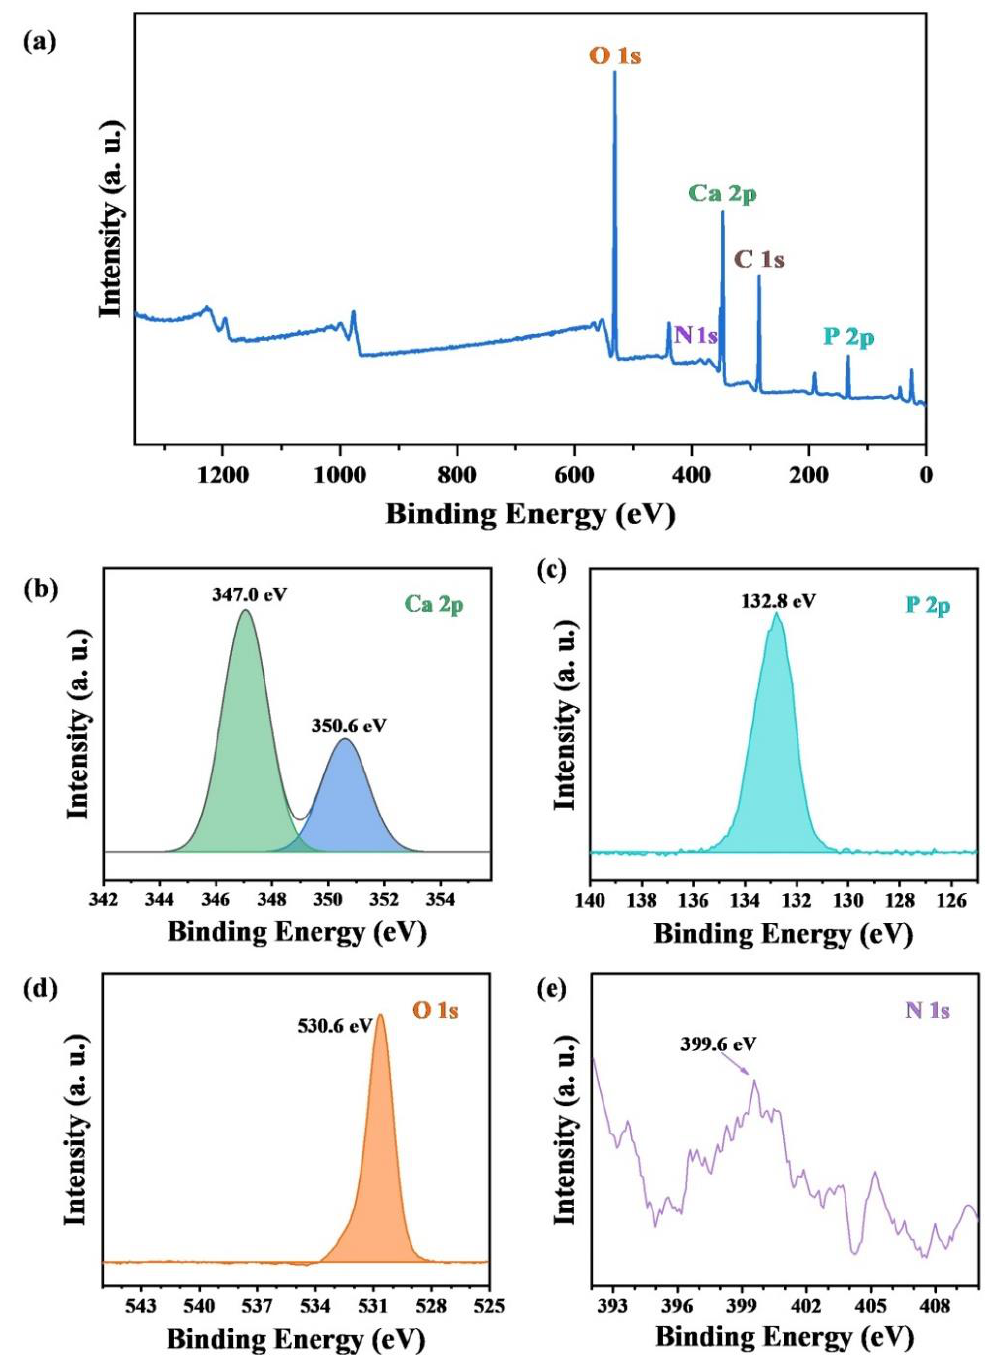
Figure 4. XPS patterns of ultralong HAP nanowires synthesized by the calcium oleate precursor microwave hydrothermal method using ATP as a bio-phosphorus source in aqueous solution at 180 ◦ C for 60 min. ( a ) Survey XPS pattern. ( b ) Ca 2p XPS pattern. ( c ) P 2p XPS pattern. ( d ) O 1s XPS pattern. ( e ) N 1s XPS pattern.